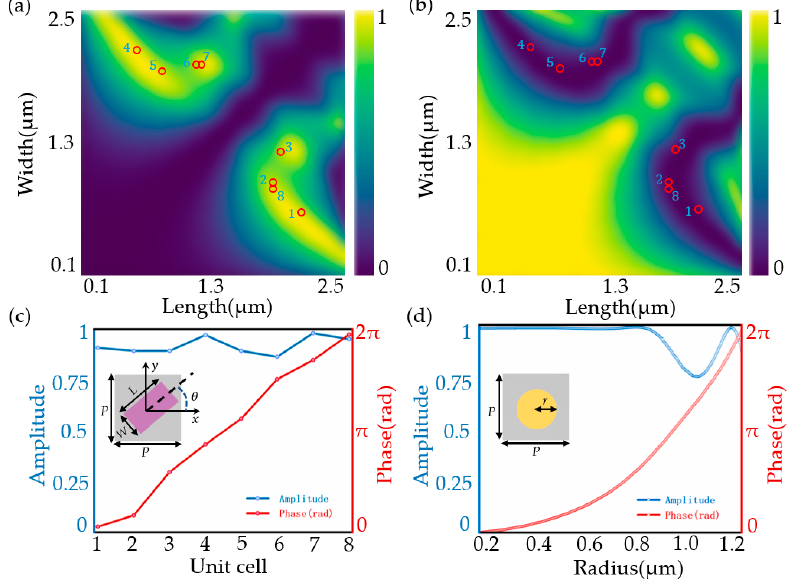
Figure 2. Transmission of cross-polarization ( a ) and co-polarization ( b ) was simulated under RCP incidence. The eight Ge nanofins marked by the red circles we selected are equivalent to the function of HWPs. ( c ) The phase change and specific transmission amplitude under RCP polarization incidence for the eight Ge cells selected (8 units in ( c ) correspond to the unit structure size marked with numbers 1-8 in ( a )). ( d ) The phase and amplitude of GSSe cylindrical cells with different radii under the excitation of RCP polarization.